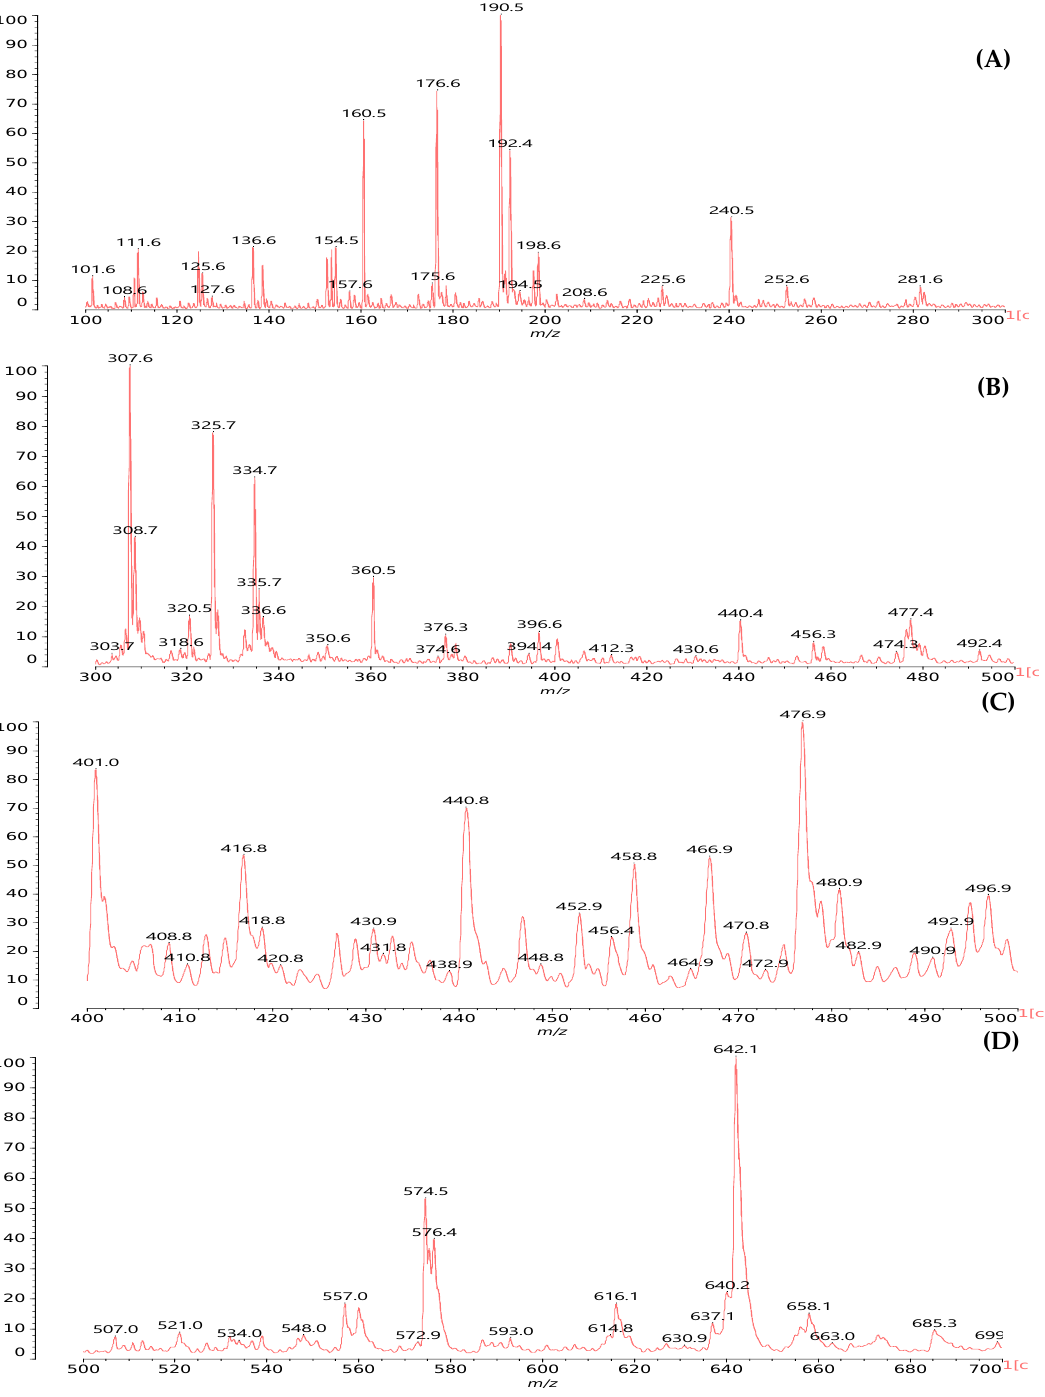
Figure 8. ( A – D ) MALDI ToF mass spectra of PFA°.